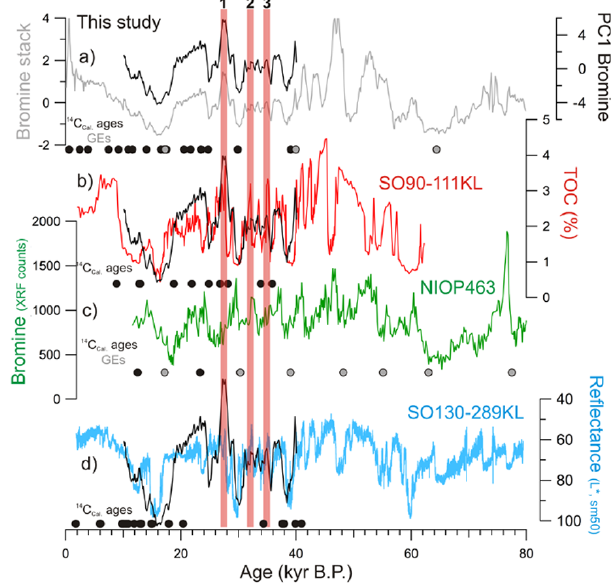
Fig. 6. Relationship between bromine stack and PC1-bromine and previously published productivity records in the Arabian Sea. (a) Bromine stack and PC1-bromine data from the present study. (b) Total organic carbon (TOC) at site SO90-111KL (Schulz et al., 1998) (see Fig. 1 for location). PC1-bromine (black) was superim- posed for comparison. (c) Bromine stack of core NIOP463 (Ziegler et al., 2010) in the OMZ (Fig. 1). (d) Reflectance at site SO130- 289KL (Deplazes et al., 2013) (see Fig. 1 for location). PC1- bromine (black) was superimposed for comparison. Radiocarbon ( 14 C dates) and GE control points for each record are indicated by black and grey dots. The three red frames indicate significant am- plitude differences between Arabian Sea